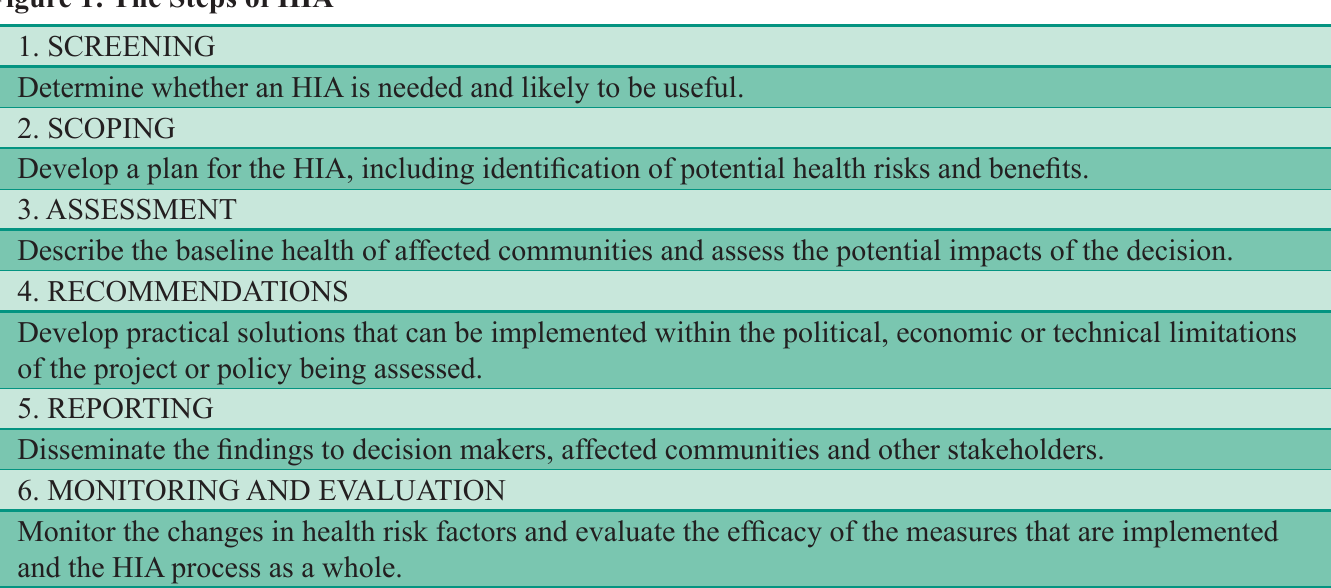
Figure 1: The Steps of